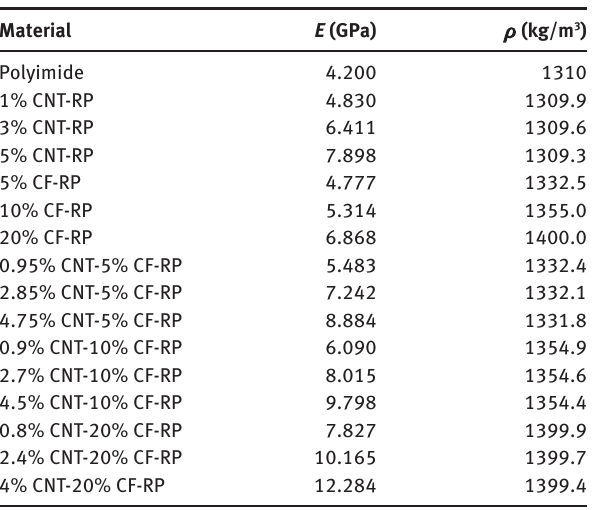
Table 3: Equivalent properties of CNT/CF-reinforced polyimide.